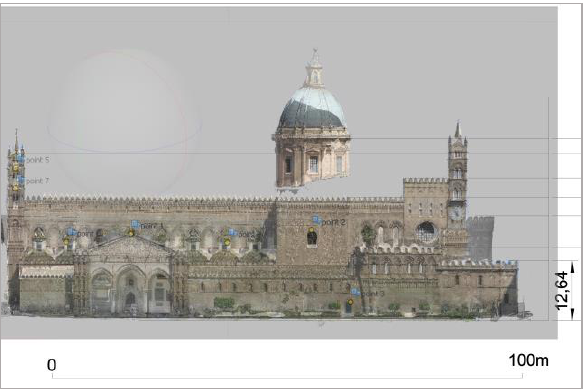
Figure 16. The aligned